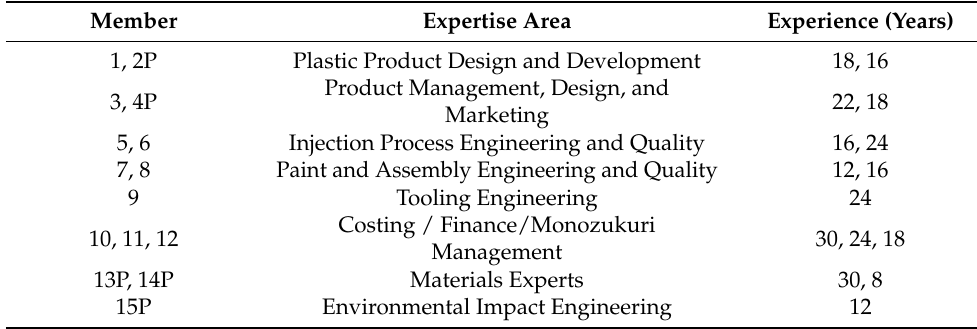
Table 1. Optimization team members: expertise area and experience.